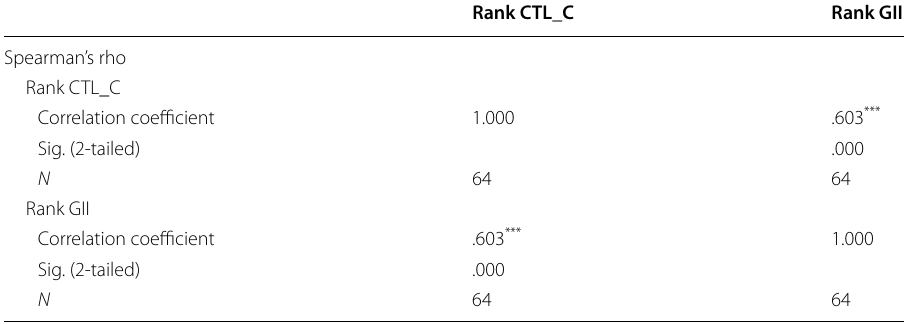
Table 1 Correlation ranks data Uz